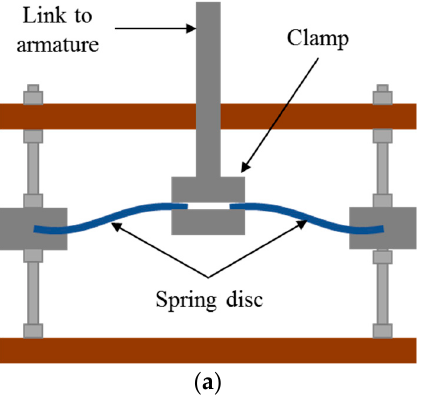
Figure 8. Disc spring mechanism: ( a ) disc spring, redrawn as depicted in [66]; ( b ) buckling spring ribbons, redrawn as depicted in [85].